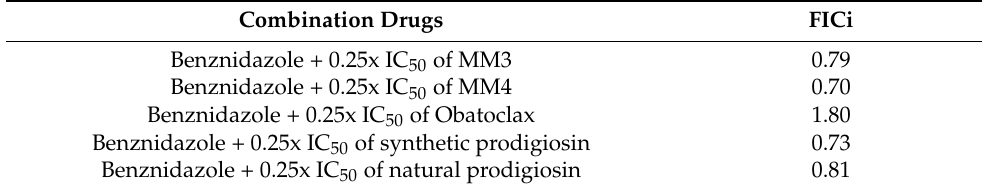
Table 3. FICi values of the combinations between benznidazole and the tested compounds at concentrations equivalent to 0.25x IC 50